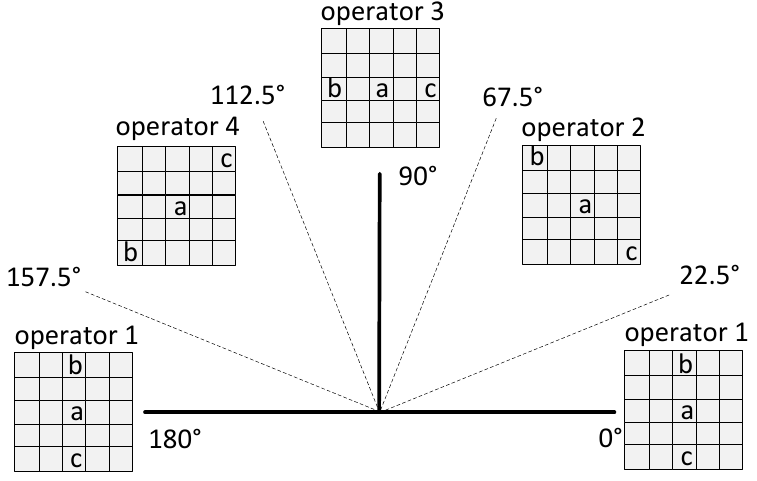
Figure 6. Four directional linear feature enhancement